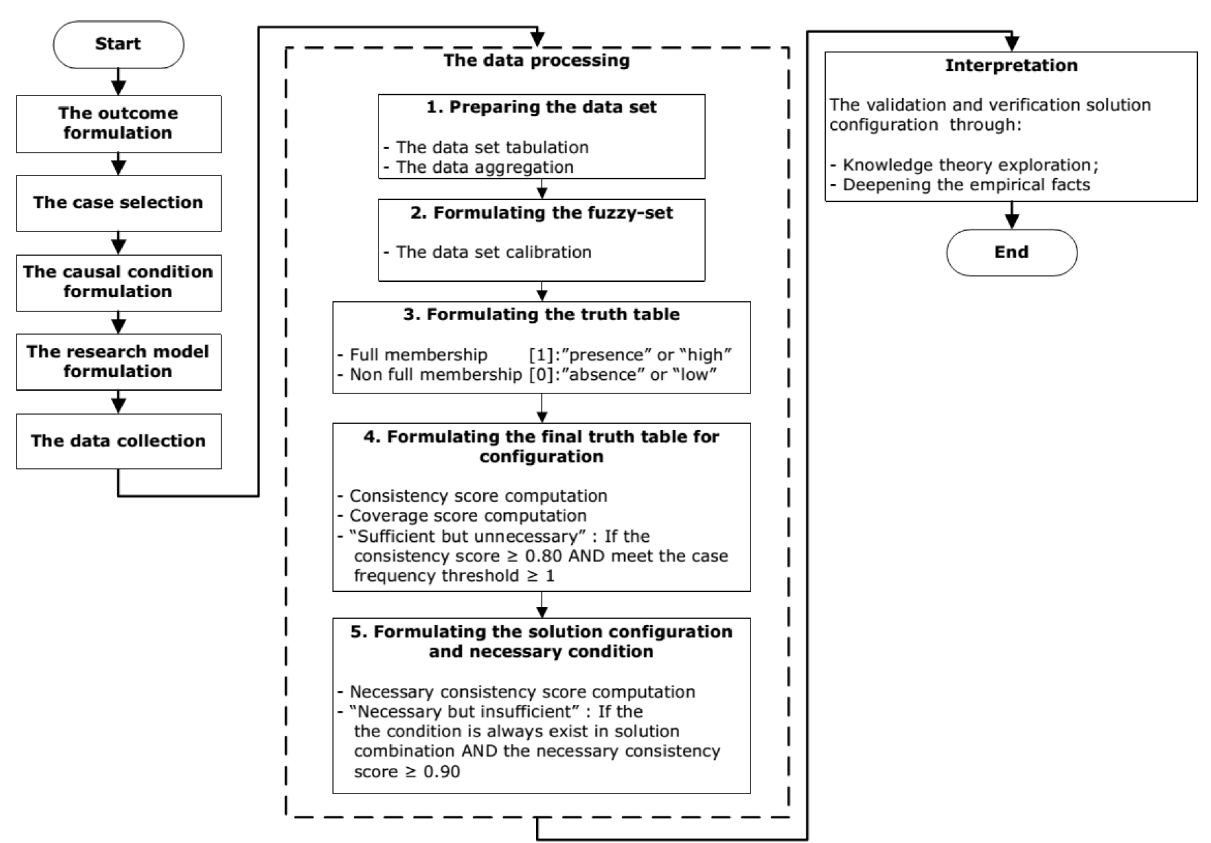
Figure 1. Flowchart of the fsQCA